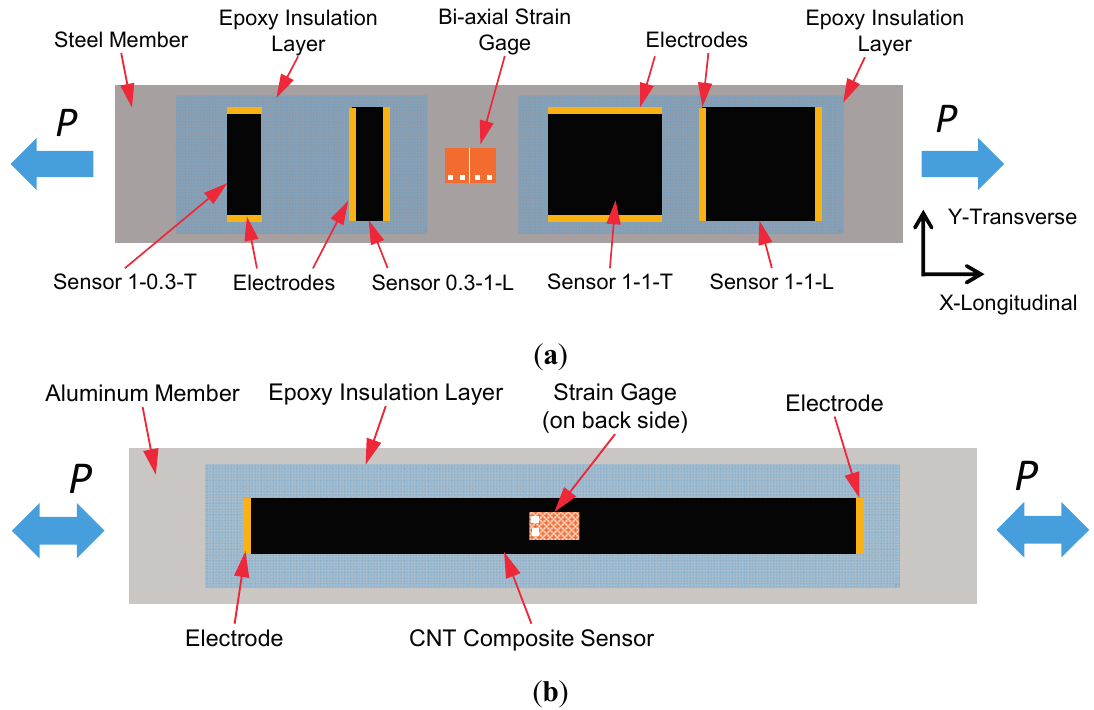
Figure 4. Schematic diagrams of test specimens for ( a ) longitudinal/transverse strain sensing on the steel substrate (Case Study 1) and ( b ) uniaxial tensile/compressive strain monitoring on the aluminum substrate (Case Study